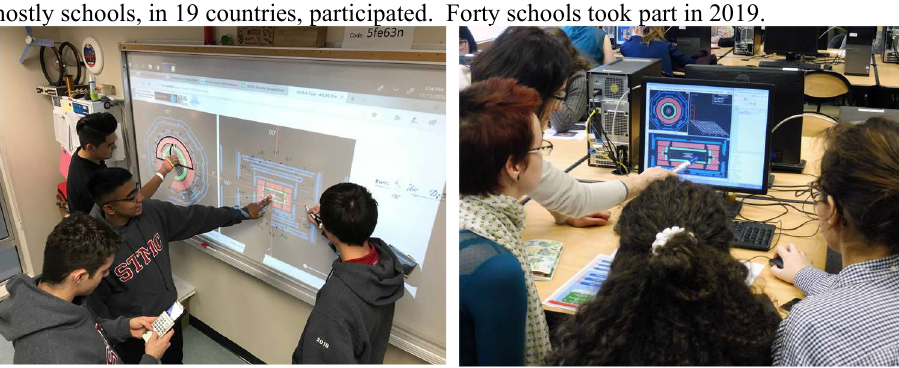
Figure 6. World Wide Data Day, Burnaby, Canada 2018: ATLAS Measurement.